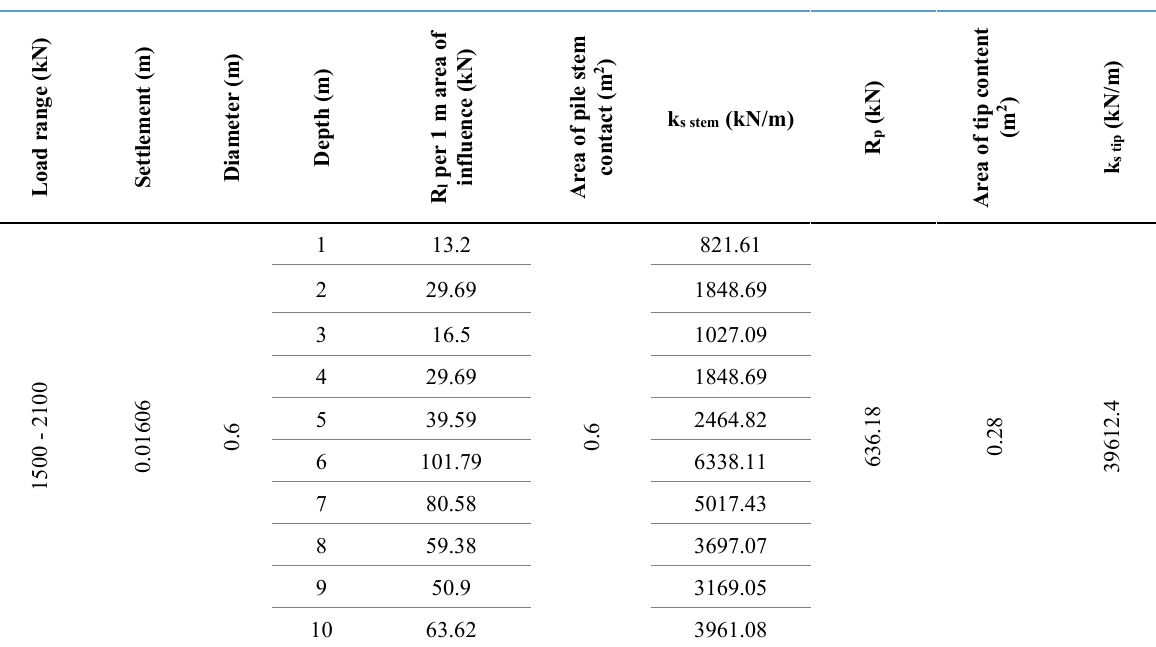
Table 3. Coefficients of vertical reaction of the